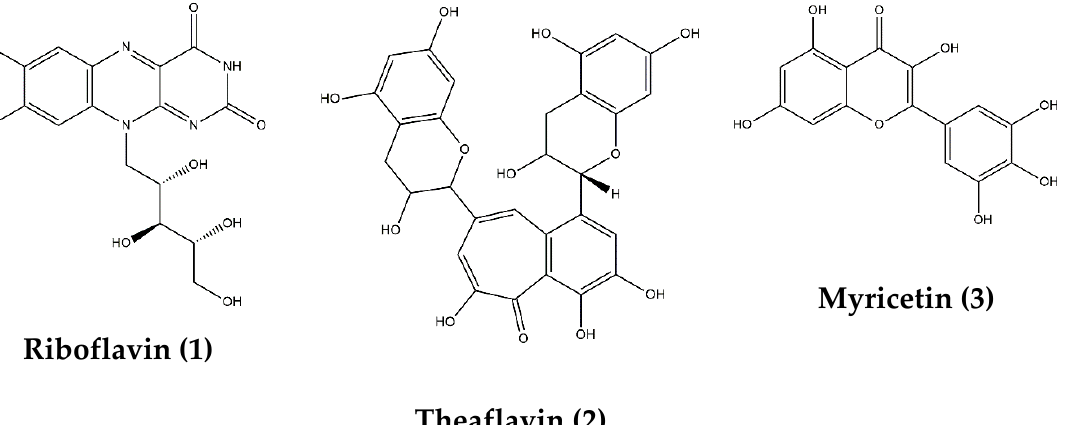
Figure 1. Chemical structures of compounds 1 – 3 isolated from maceration of B. gymnorhiza fruit but reported absent in decoction.